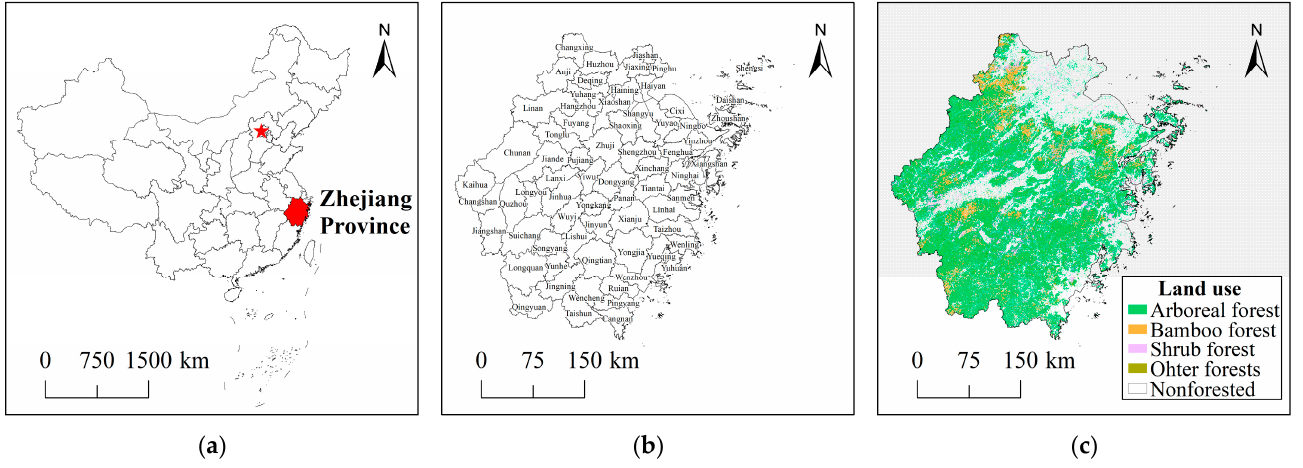
Figure 1. ( a ) Location of Zhejiang Province within China, ( b ) administrative map of the 66 counties in Zhejiang Province, and ( c ) distribution of forest resources in Zhejiang Province.